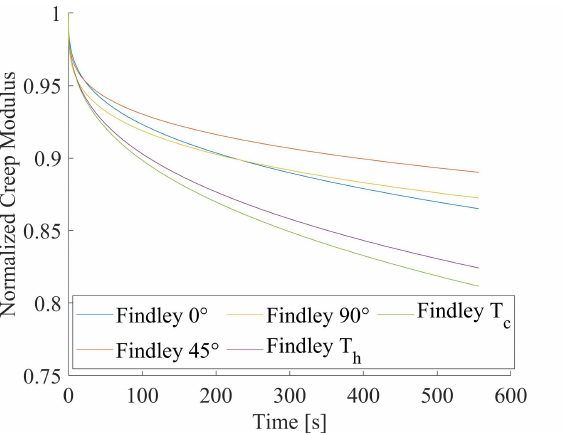
Figure 8. Comparison of stress relaxation curves by Findley